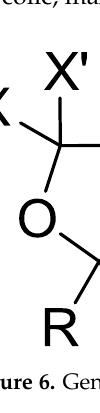
characterization, Figure S5: ESW investigation, Figure S6: Operative voltage investigation, Figure S7: Nyquist plot analysis and resistances evaluations, Table S1: ESW data at different current densities cut-off, Table S2: Relevant performance from cited